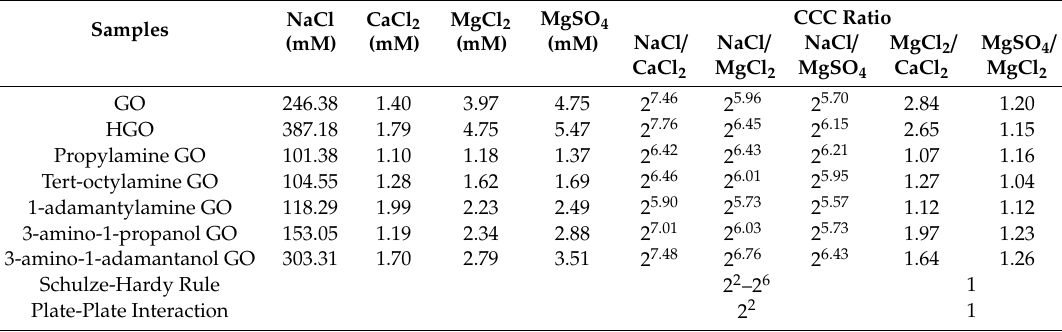
Figure 3. Attachment efficiency of ( a ) the GO and ( b ) the HGO as a function of salt concentration; NaCl (blue), CaCl 2 (red), MgCl 2 (dark yellow), and MgSO 4 (dark green). Table 2. Summary of the critical coagulation concentration